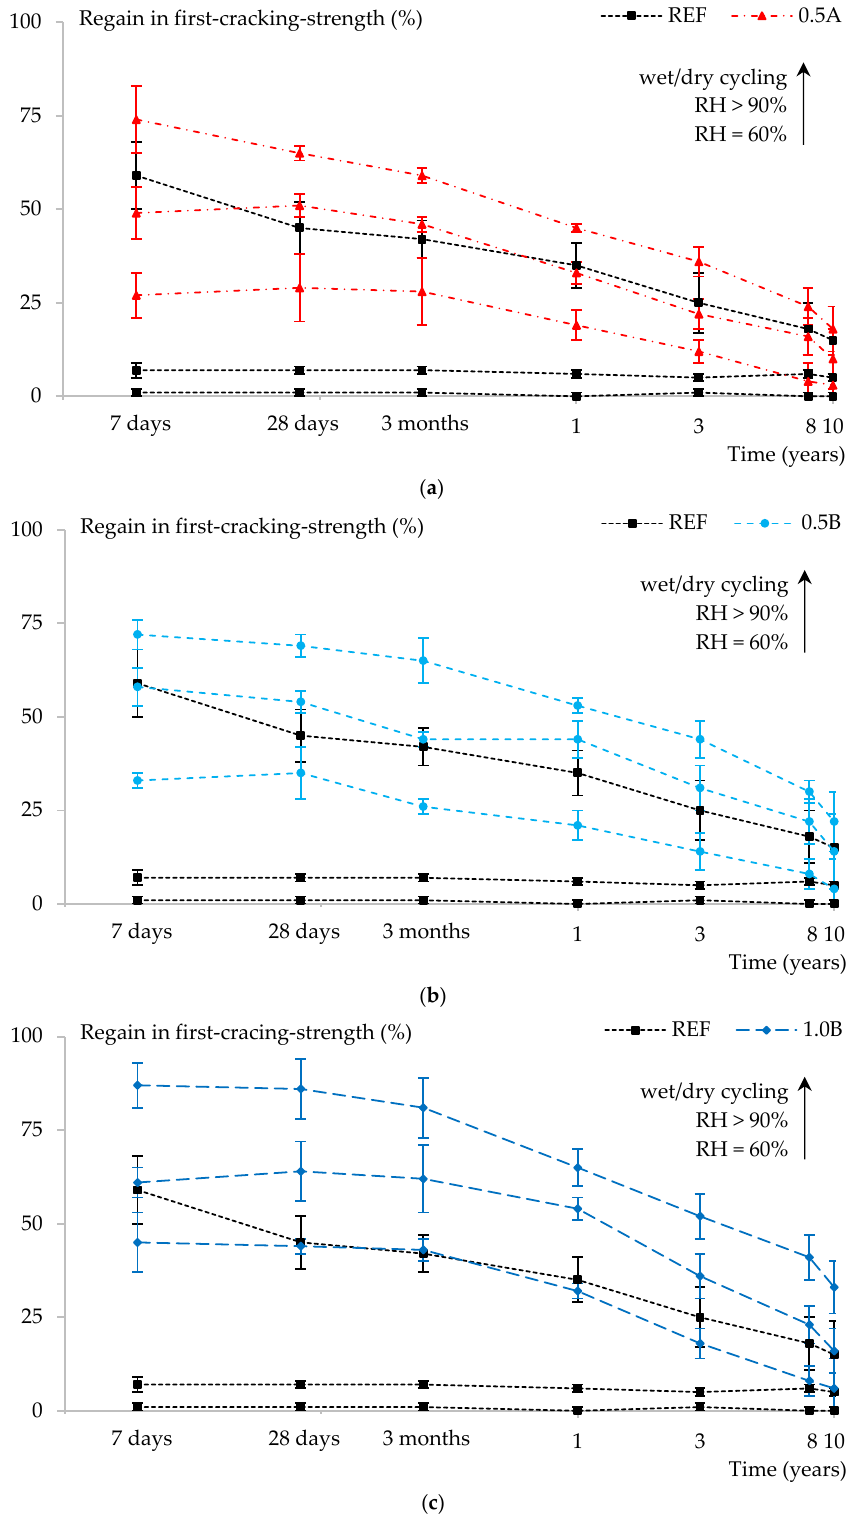
Figure 4. The measured regain in first cracking strength after curing in wet/dry cycling; a high relative humidity of more than 90%; and a relative humidity of 60% of: ( a ) 0.5 m% of SAP A compared to reference samples, ( b ) 0.5 m% of SAP B compared to reference samples, and ( c ) 1.0 m% of SAP B compared to the reference samples.